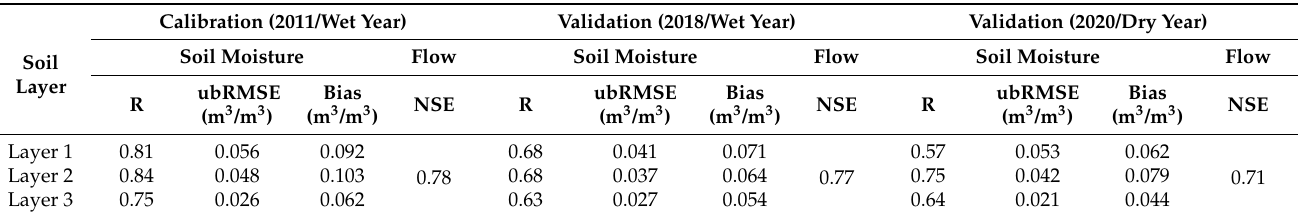
Table 1. Calibration and validation performance of the model in terms of correlation coefficient